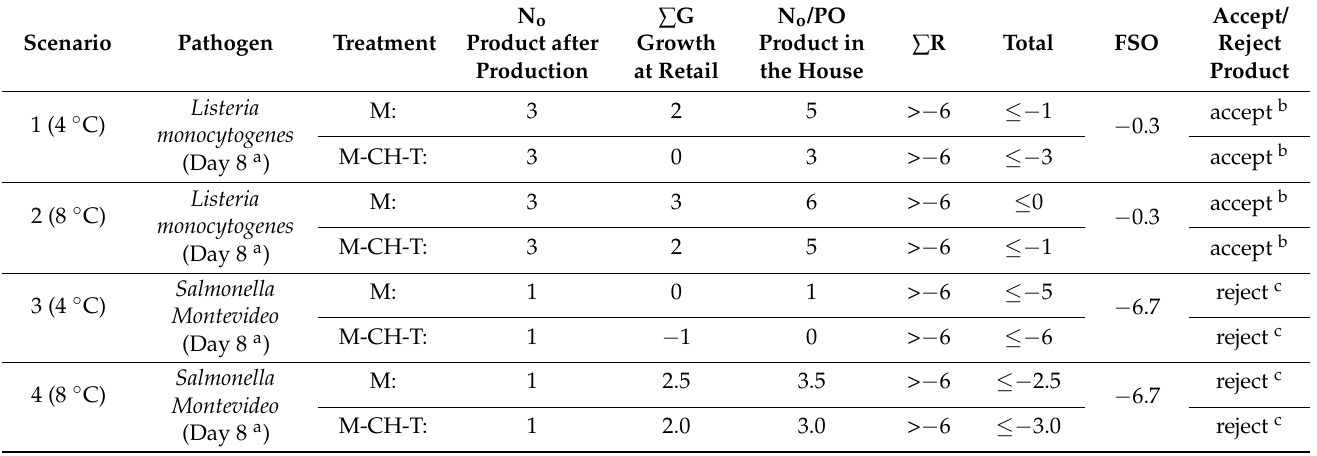
Table 2. Determination of PO and evaluation of FSO in the food chain of the RTC product stored under MAP conditions (commercial product, treatment M), and in presence of Chitosan-Thyme oil (treatment M-CH-T) at recommended chill (4 ◦ C) and abuse (8 ◦ C) temperatures with different scenarios. M denotes RTC product stored MAP, M-CH-T denotes product treated with Chitosan and Thyme, stored under